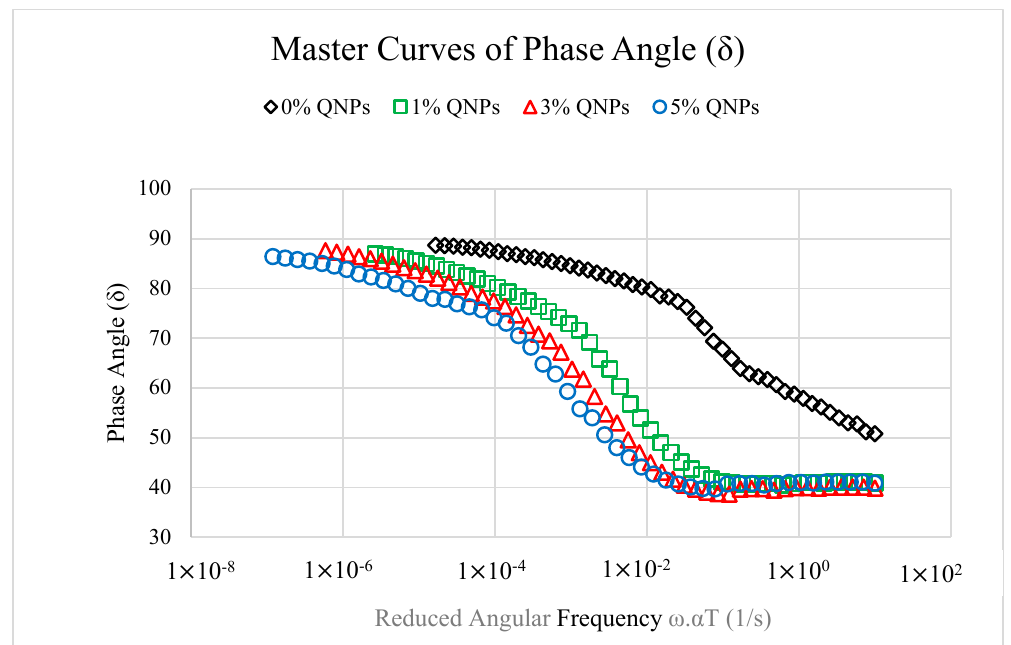
Infrastructures 2022 , 7 , x FOR PEER REVIEW Figure 11. Master curves of the phase angle of all samples. Figure 11. Master curves of the phase angle of all samples. Master curves of rut resistance G*/sin δ were plotted at 30 °C between reduced angu ‐ lar frequencies on the horizontal “ x ‐ axis” and rut resistance G*/sin δ on the vertical “ y ‐ axis.” The main purpose of master curves is to check the behavior of QNP ‐ modified bitu ‐ men at high temperatures as per SHRP rutting resistance criteria, i.e., G*/sin( δ ) > 1 kPa. The maximum failure criteria for modified bitumen samples were recorded based on these results. The master curves were constructed using the software “Rheoplus.” Master curves of rut resistance G*/sin δ were similar to the complex modulus G* trend. Figure 12 illustrates that all the samples passed the criterion G*/sin δ > 1 kPa, including 1% QNPs at the selected maximum temperature (70 °C) compared to virgin bitumen, and this trend continues up to 5% QNPs. Thus, 5% QNP modification showed better rut resistance per ‐ formance than all samples at lower percentages. Overall, it can be concluded that the 5% QNP mixture had shown the best rut resistance among all the samples, and it is suitable to use in higher temperature zones.